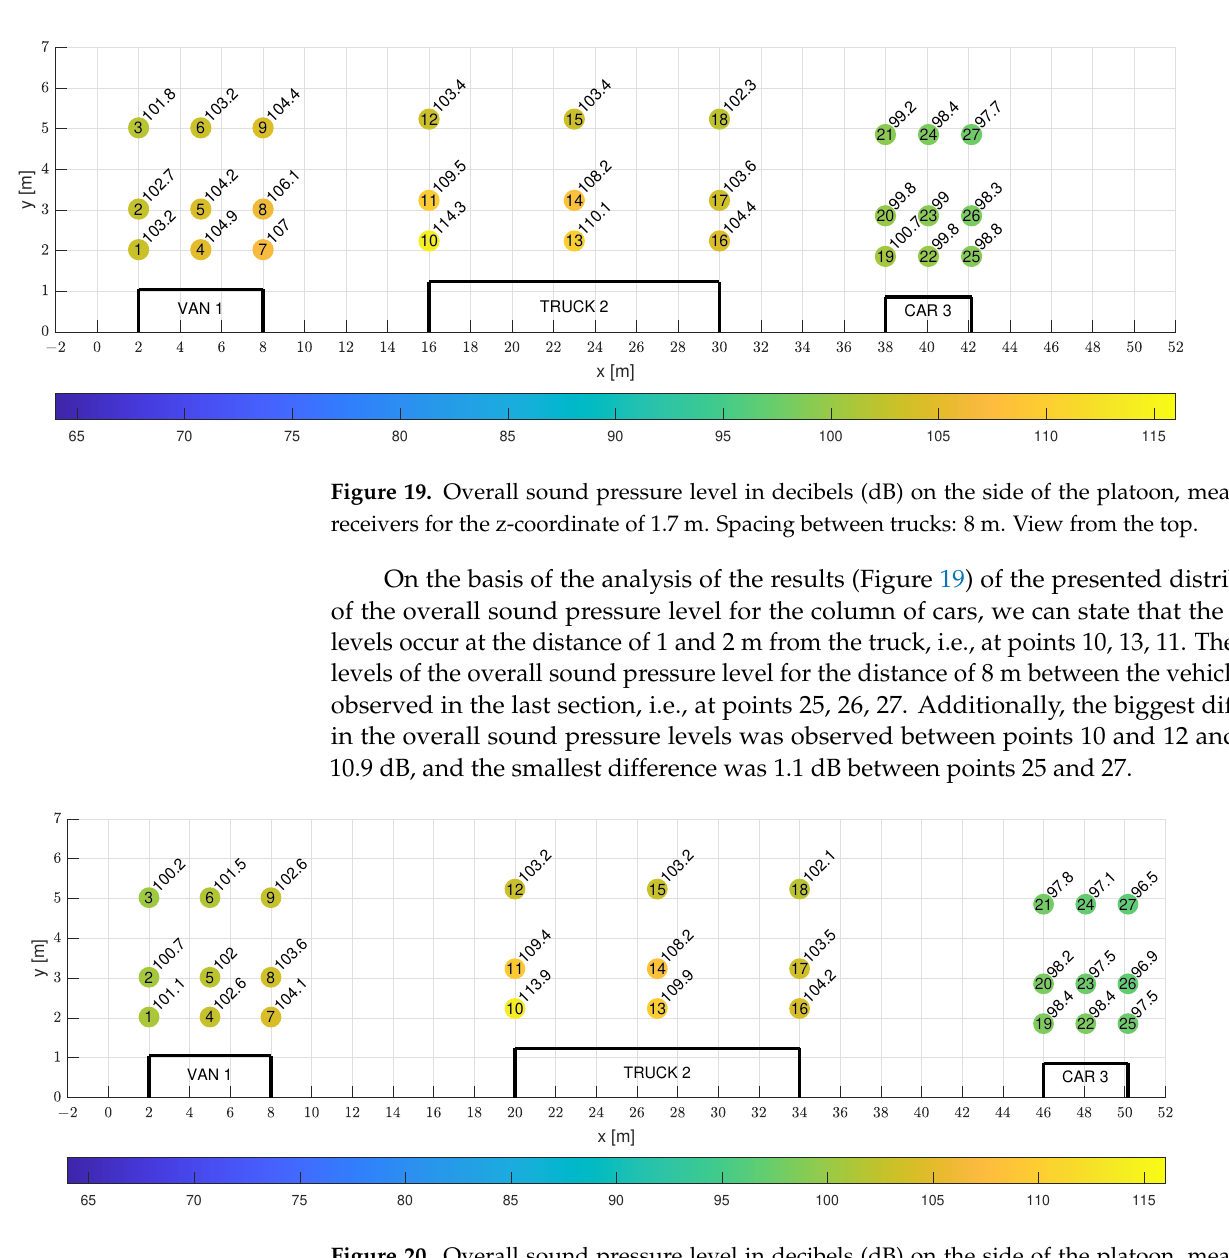
a passenger car and a van are sources that differ in levels by 0.6 and 0.7 dB at a distance of 4 m. Because of the significant differences between the overall sound pressure levels at points in close proximity to individual vehicles and car columns, it was decided to perform additional calculations at a distance of 15 m and a height of 4 m and to determine